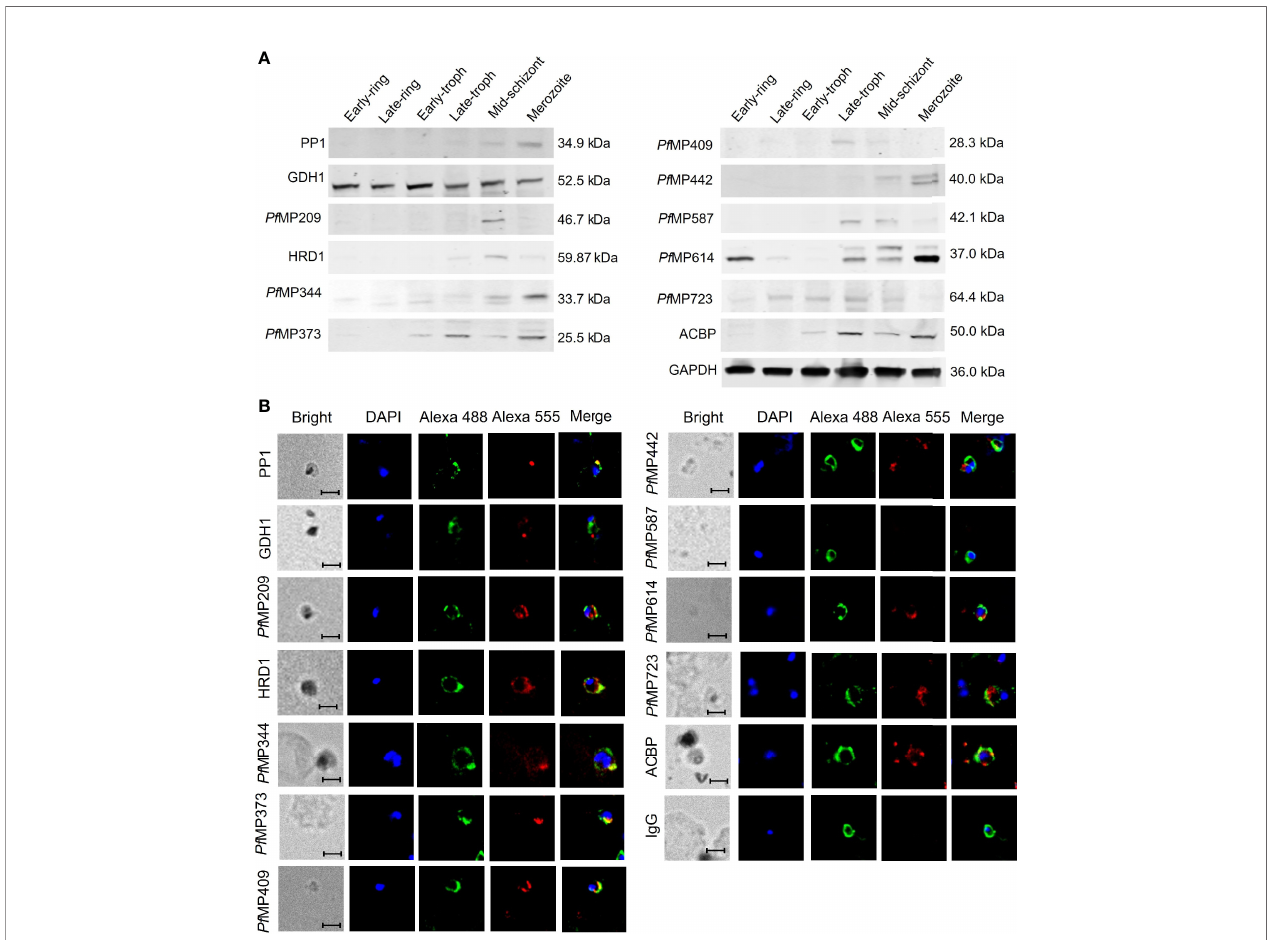
FIGURE 3 | Expression of merozoite-associated proteins during the erythrocytic developmental stages of Plasmodium falciparum . (A) Expression of merozoite proteins in the six erythrocytic stages of P. falciparum 3D7 detected by western blot with total IgG from rabbit sera against each protein and glyceraldehyde-3- phosphate dehydrogenase B (GAPDH) as an internal reference. (B) Localization of the merozoite proteins in the merozoites shown by immuno fl uorescence. All samples were incubated with total IgG from rabbit sera against each merozoite protein or IgG control derived from naïve rabbits, total IgG from mice sera against MSP-1 were used for co-location. Alex Flour 555 donkey anti-rabbit IgG (red fl uorescence) and Alex Flour 488 donkey anti-mouse IgG (green fl uorescence). Green, anti-MSP1; Red, anti-individual candidate protein as indicated. Nuclei are stained with DAPI (blue). Scale bar: 5 m m. PP1, serine/threonine protein phosphatase 1; GDH1, nicotinamide adenine dinucleotide phosphate-speci fi c glutamate dehydrogenase; Pf MP, P. falciparum merozoite protein; HRD1, endoplasmic reticulum- associated degradation-associated E3 ubiquitin-protein ligase 1; ACBP, acyl-CoA binding protein; MSP-1, merozoite surface